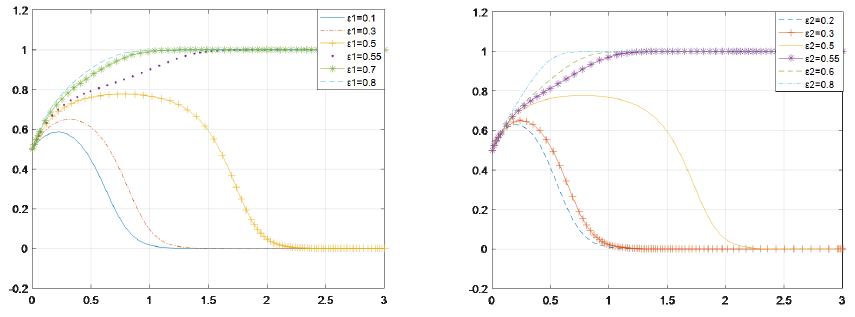
Fig. 5 The influence of ε on the shared strategy of